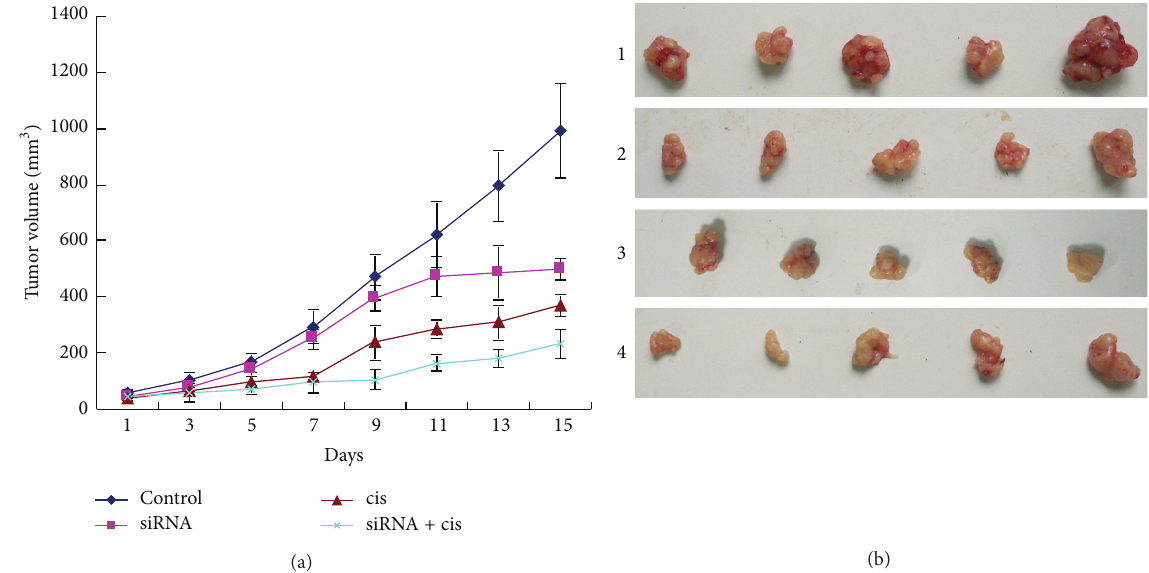
Figure 3: Tumor regression observed in EC9706 xenografts treated with different ways. (a) Tumor volumes from the xenografts of groups each were assessed every day, as described in Materials and Methods, and the results were expressed as means ± SE (mm 3 ). The tumor growth of treated groups each became slow, in which group treated with mTOR siRNA combined with cisplatin was the slowest. (b) Tumors from the xenograft treated with different ways for two weeks. 1, 2, 3, and 4 represent control, mTOR siRNA, cisplatin, and mTOR siRNA + cisplatin groups, respectively. Table 3: Effects of mTOR siRNA and cisplatin alone or combined on growth of human ESCC xenograft in nude mice ( 𝑛 = 5 ). Group Animal weight Tumor volume at beginning 1 Tumor volume at termination Inhibition rate of tumor (%) Control 20.54 ± 1.23 57.03 ± 10.45 999.28 ± 167.30 — siRNA 20.52 ± 2.08 43.62 ± 10.85 416.97 ± 38.12 ∗ 58.27 cis 20.38 ± 1.42 39.09 ± 2.08 367.91 ± 61.21 ∗ 63.18 siRNA + cis 20.66 ± 1.79 46.28 ±